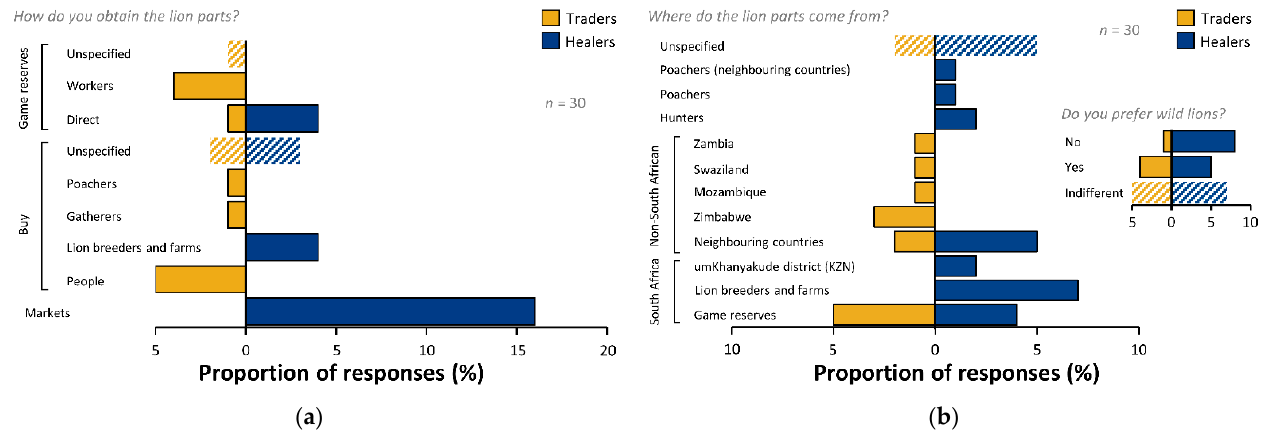
Figure 5. Acquisition and source of lion body parts: ( a ) how parts are obtained, and ( b ) where parts come from, including stated preference for wild-sourced lions.